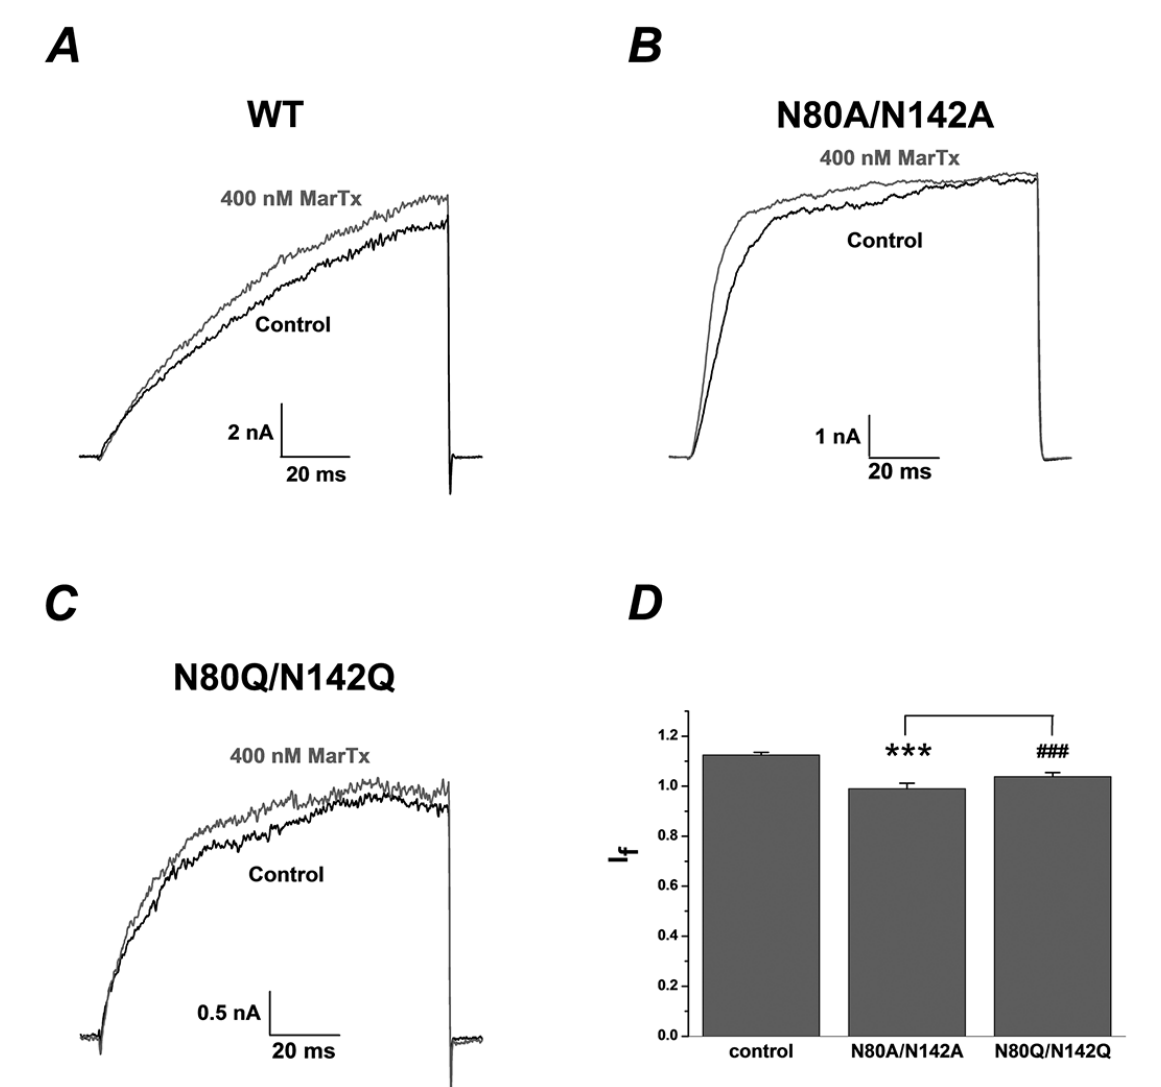
Figure 3. Deglycosylation of β 1 subunit removed the enhancement effect of martentoxin on BK channels ( α + β 1). (A) Representative whole cell current traces from HEK 293T cells expressing wild-type BK channels ( α + β 1) before and after the application of martentoxin 400 nM. The holding voltage was -80 mV and the currents were elicited by a pulse of +100 mV in the presence of 300 nM free Ca2 + in the pipette solution. (B) Representative whole cell current traces from HEK 293T cells expressing mutant BK channels N80A/N142A before and after the application of martentoxin 400 nM. (C) Representative whole cell current traces from HEK 293T cells expressing mutant BK channels N80Q/N142Q before and after the application of martentoxin 400 nM. (D) Statistical analysis of pharmacological modulation of wild-type BK channels ( α + β 1) (n = 6) and N80A/N142A (n = 5, ***p < 0.001) or wild-type BK channels ( α + β 1) (n = 6) and N80Q/N142Q (n = 6, ###p < 0.001) by martentoxin 400 nM. The effect ratios of martentoxin on the currents of N80A/N142A and N80Q/N142Q were not significantly different (p >